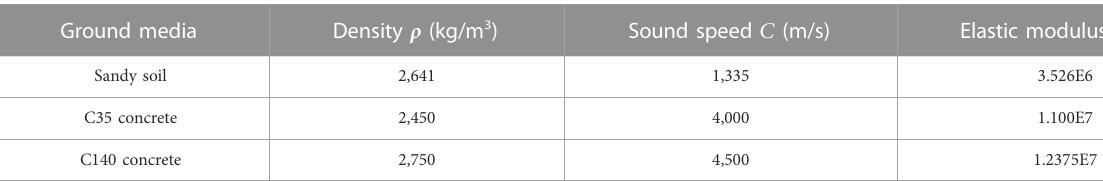
TABLE 7 Ground propagation medium material property parameters.